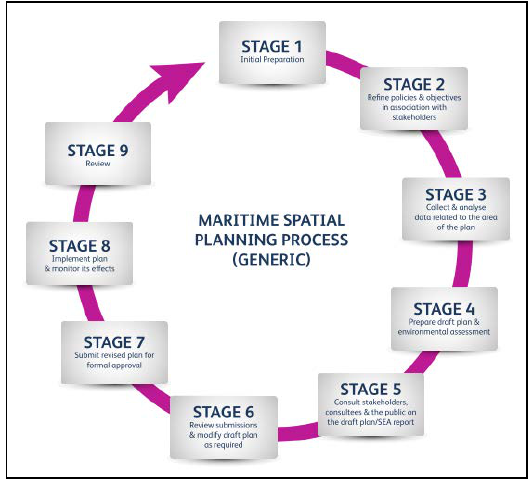
Figure 2. Marine Spatial Planning Process (Heffernan, 2015)